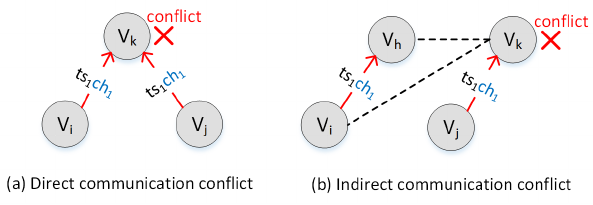
Figure 2. Example of communication